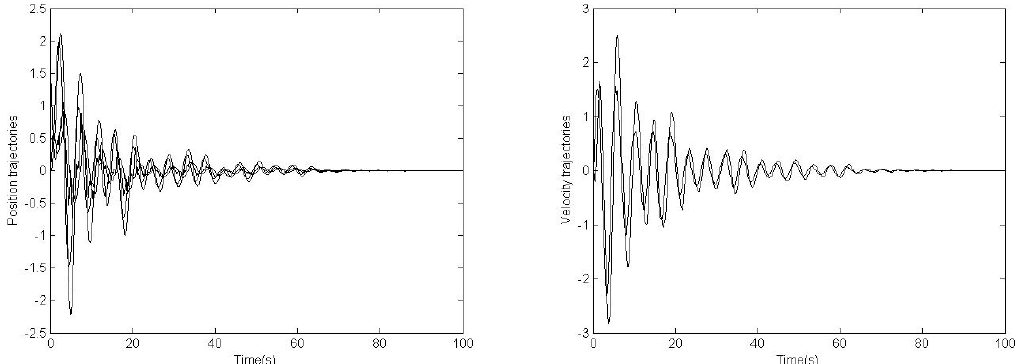
Figure 2. Trajectories of systems (1), (3), (4) with consensus algorithm (7).